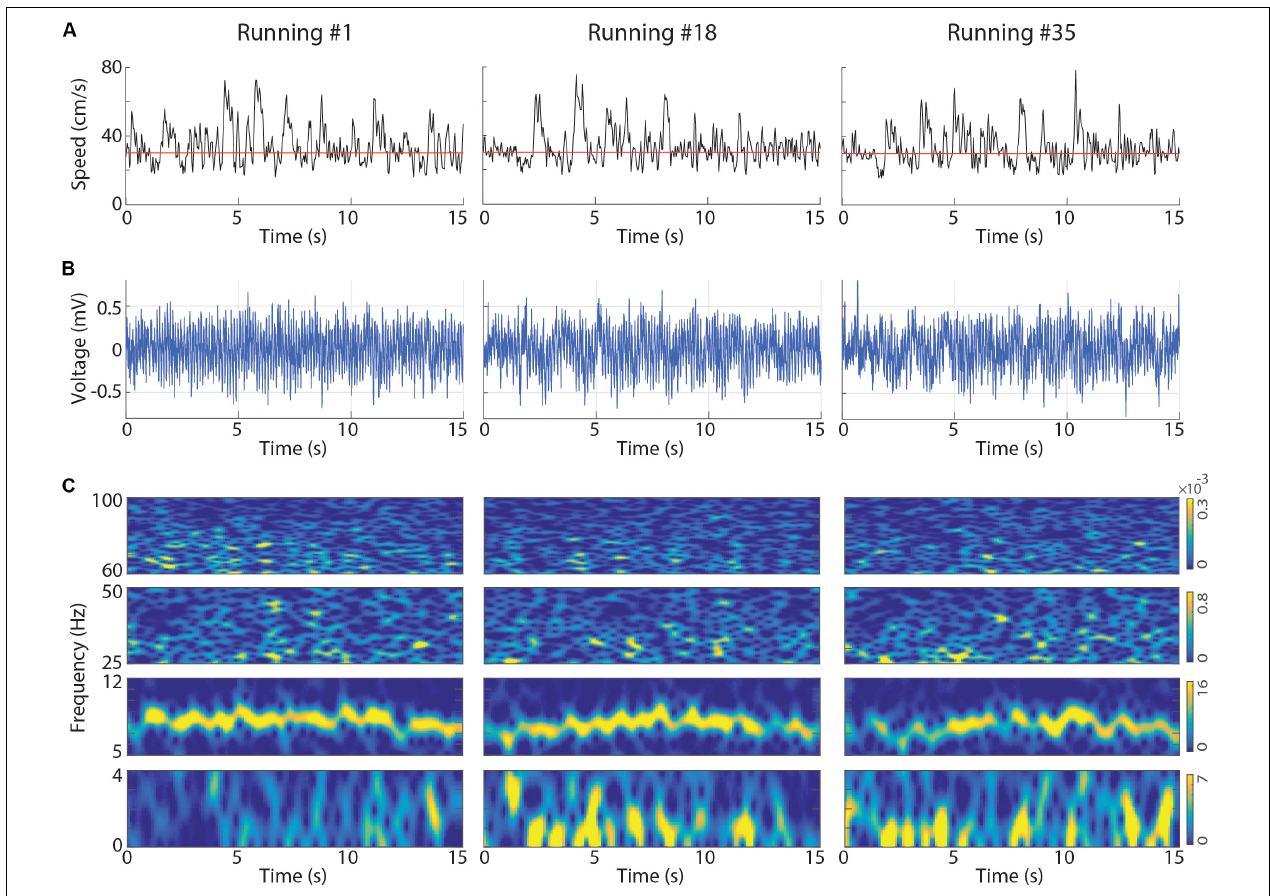
FIGURE 2 | Representative examples of instantaneous running speed and LFP signals at the first, at an intermediate and at the last treadmill running. (A) Black lines represent the instantaneous running speed and red lines represent treadmill speed (30 cm/s). The CA1 LFPs (B) and associated spectrograms (C) obtained for the same runs. In the spectrograms, delta (0–4 Hz), theta (5–12 Hz), low gamma (25–50 Hz) and high gamma (60–100 Hz) bands are shown separately to allow individual colormap scales (the scale is the same across runs). Notice the gradual reduction of theta power and the emergence of a slower LFP activity in the delta band. LFPs obtained from the dorsal CA1 of the left hemisphere